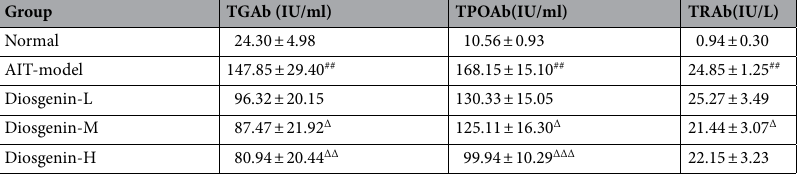
Table 2. Comparison of serum TGAb, TRAb and TPOAb expression in rats of each group. Note: # Compared with normal group, P < 0.05; ## Compared with the normal group, P < 0.01; Δ Compared with the model group, P < 0.05; ΔΔ Compared with the model group, P <